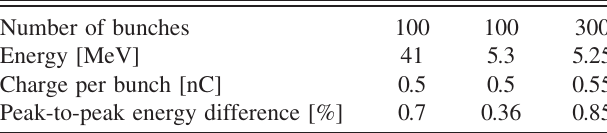
TABLE II. Measurement results for multibunch